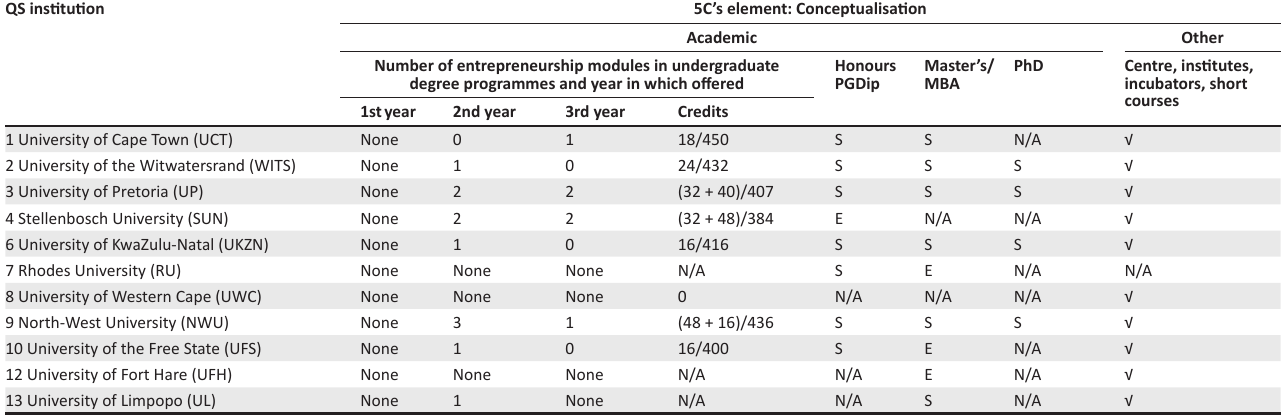
TABLE 4: Configuration of entrepreneurship education at traditional South African